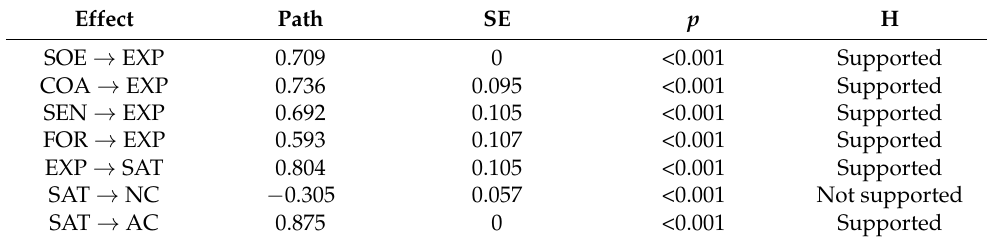
Table 5. Structural model